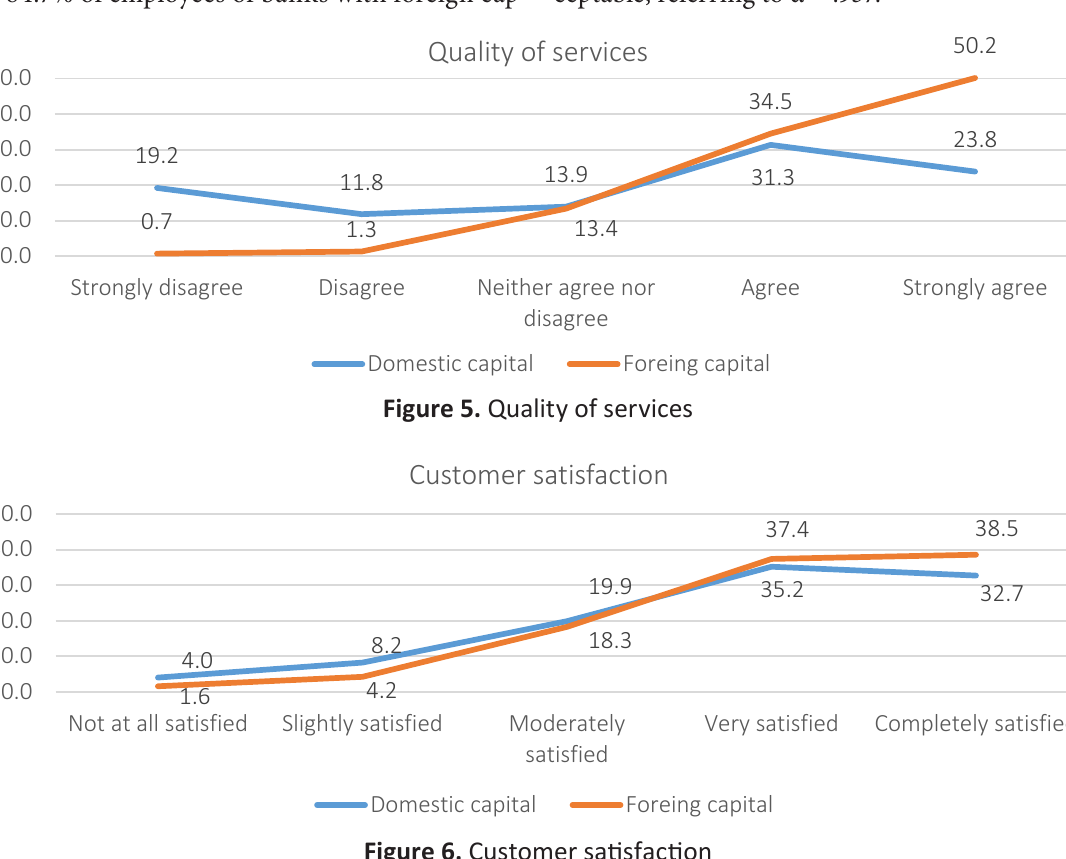
Figure 6. Customer